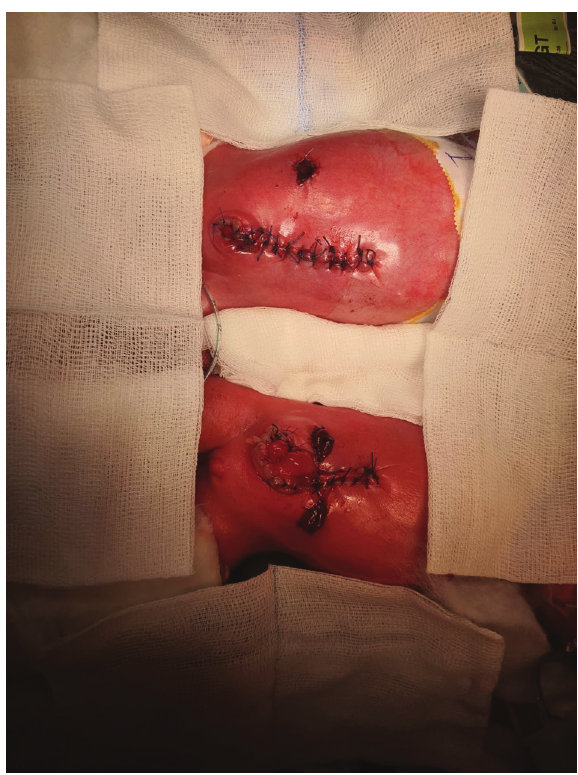
Fig. 3 An immediate post-operative image of both babies. Note the end ileostomy in baby 1 and an end colostomy with a mucous fi stula in baby 2. A vesicostomy was created in both